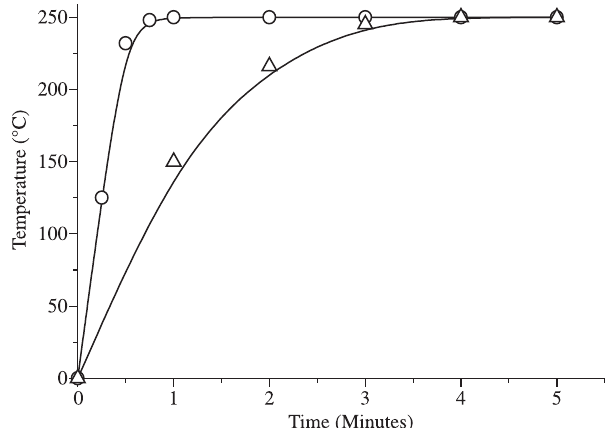
Figure 5. Variation of sensor voltage with time for different idle time of the sensor element (  ) 6 hours, (  ) 12 hours, (  ) 18 hours and (  ) 24